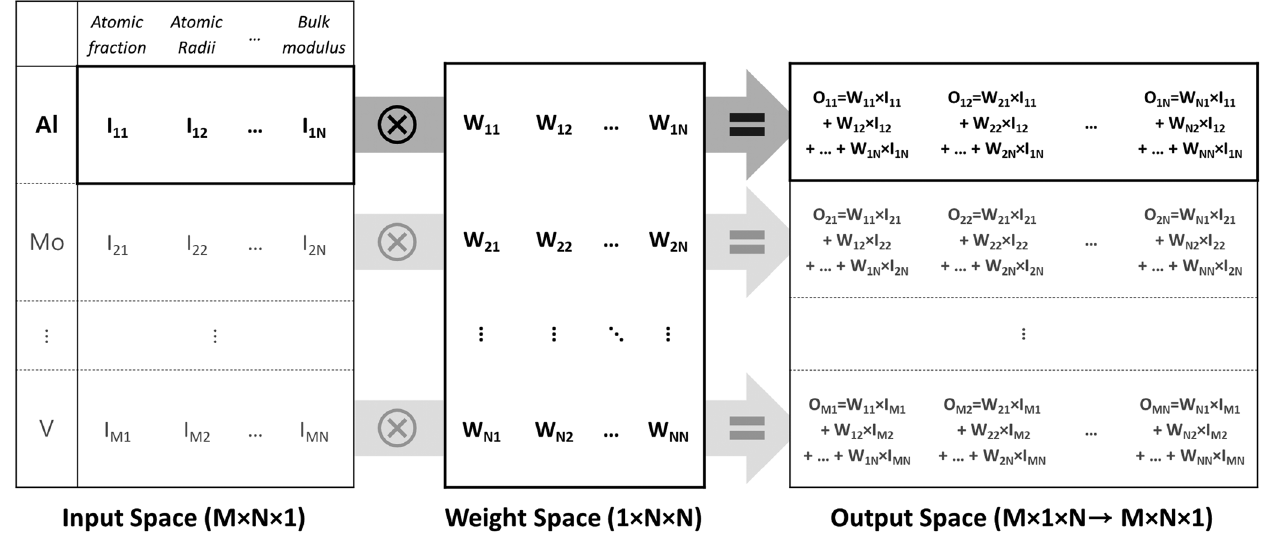
Fig. 2 Simpli fi ed graphic description of the smallest repeated layers used in the CNN part. The output space has the same shape as the input space thanks to the kernel (weight space). Due to the structure of the layers, it is possible to process a lot of information even when using a small number of weights, and repeated hidden layers allow the model to learn complex correlations between input features and